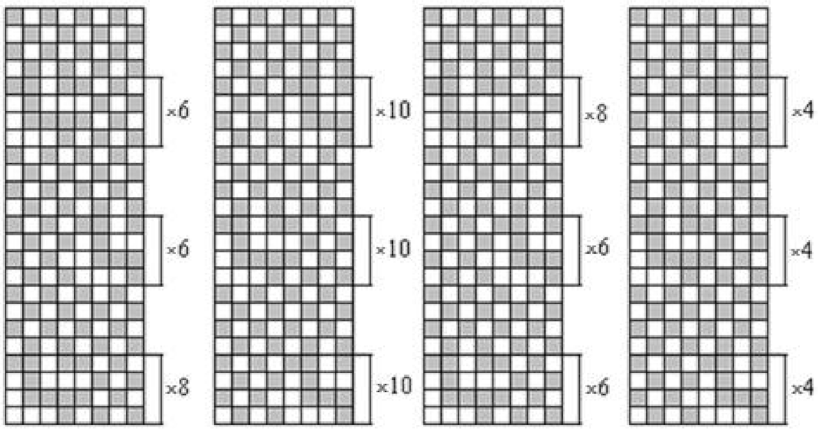
Figure 2. Cards of woven fabrics. Yarns were dyed in the department of yarn dyeing in the “Klasikin˙e tekstil˙e”